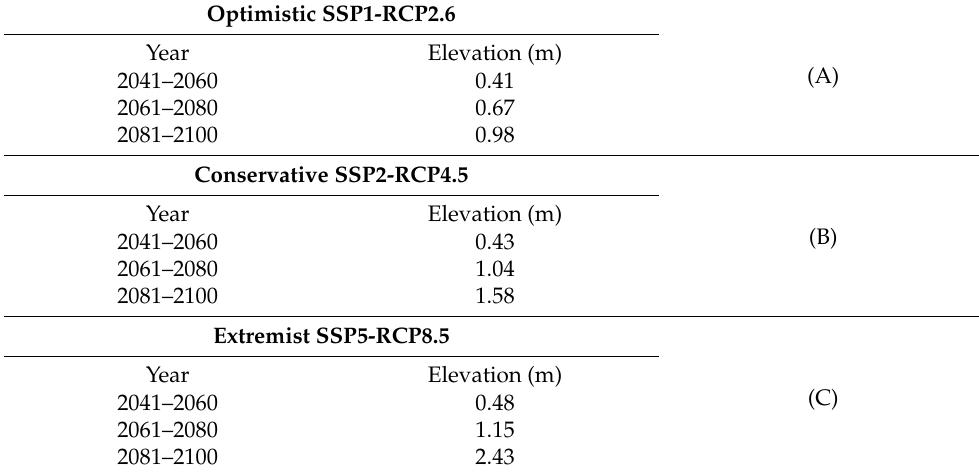
Table 2. Sea level increase in centimeters for scenarios (A) Optimistic SSP1-RCP2.6, (B) Conservative sea level projections are based on the climate projections made by Kopp et al.